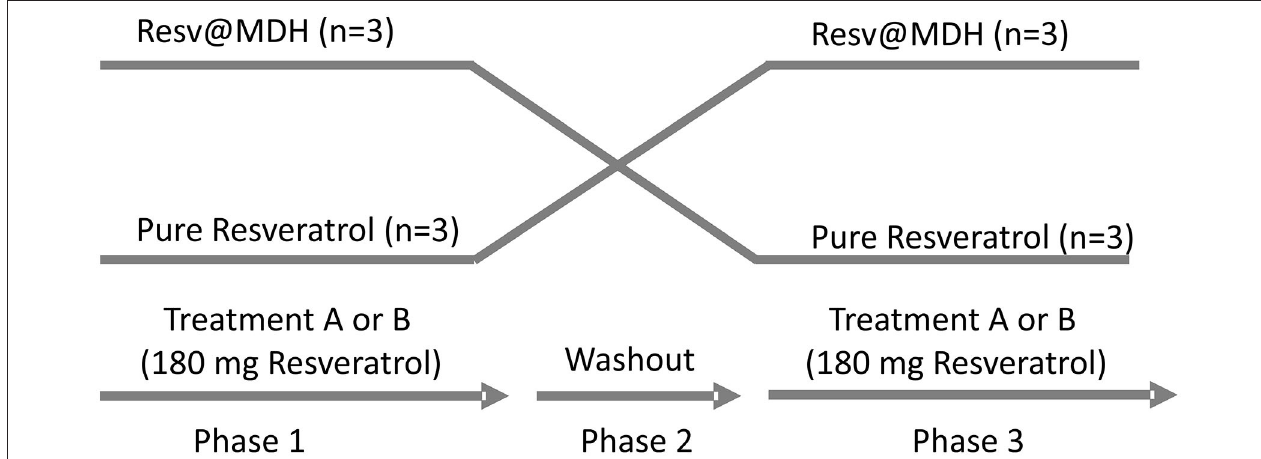
FIGURE 1 | Study design. Randomized, open label, single blind crossover study. Two single-dose treatments of resveratrol were administered orally with a 1-day intermediate washout period. The treatments consist of a solution of either (A) 180mg pure Resveratrol (Polygonum cuspidatum 98%) or (B) 180mg Resveratrol from